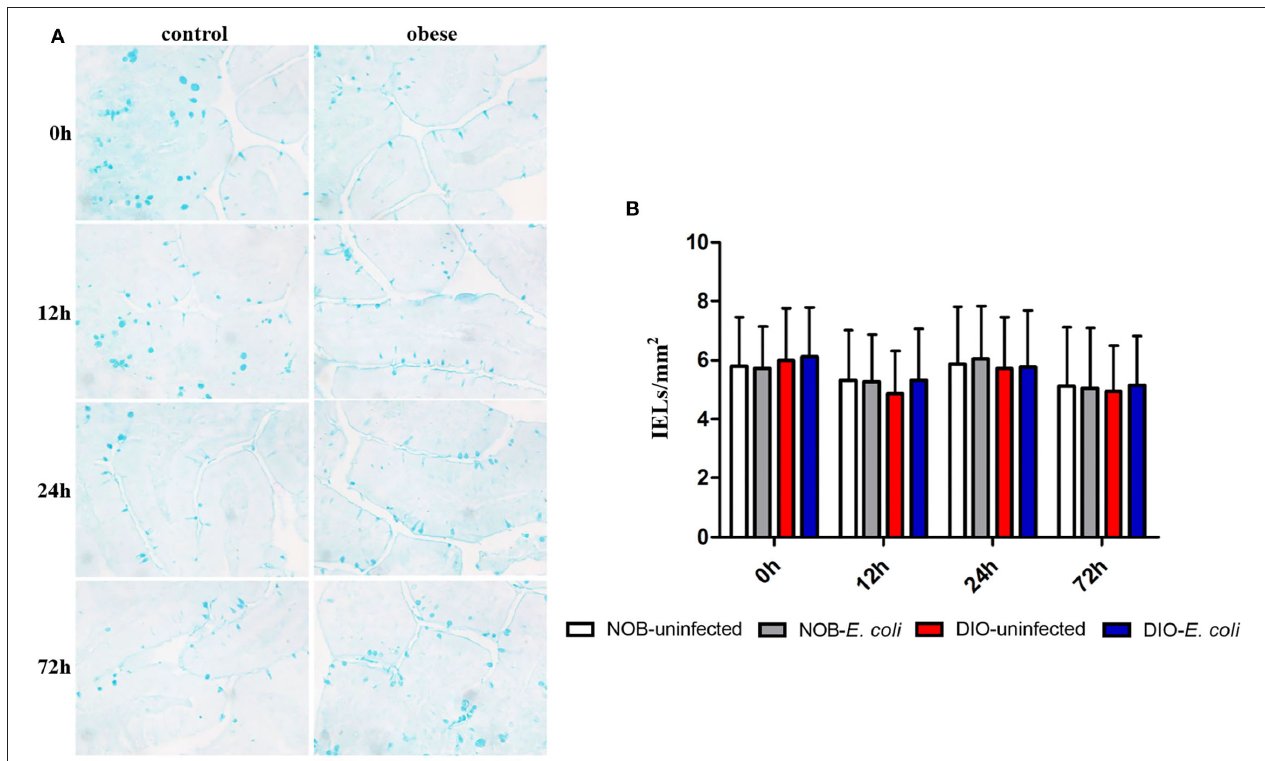
FIGURE 4 | The counting of duodenal goblet cells of each group in 0, 12, 24, and 72h post-infection. (A) Representative photomicrographs of goblet cells stained by alcian blue and periodic acid-Schiff (AB-PAS) in duodenum of mice in control (NOB- E. coli ) and obese (DIO- E. coli ) group. 0, 12, 24, and 72h were the time points after the mice were nasally instilled with E. coli . Images were taken at 400 × magnification. n = 8 mice per group. The blue dotted areas in the picture are the goblet cells. (B) Statistical analysis of duodenal goblet cells counts per mm 2 in sections stained by AB-PAS of each group in 0, 12, 24, and 72h